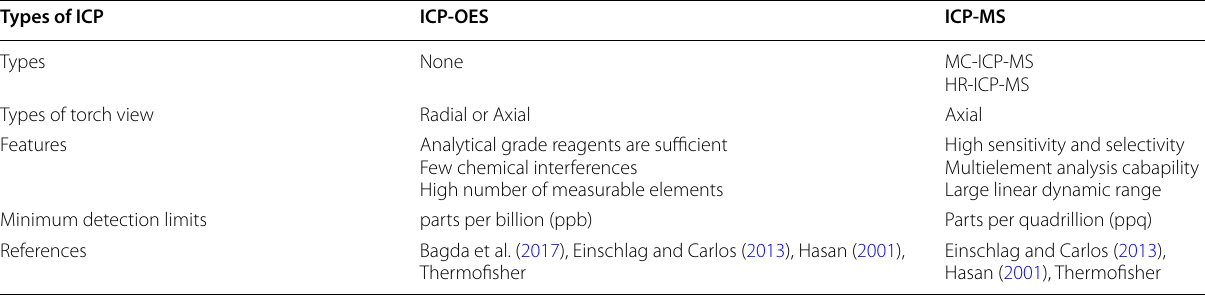
Table 2 Summary of ICP-OES and ICP-MS